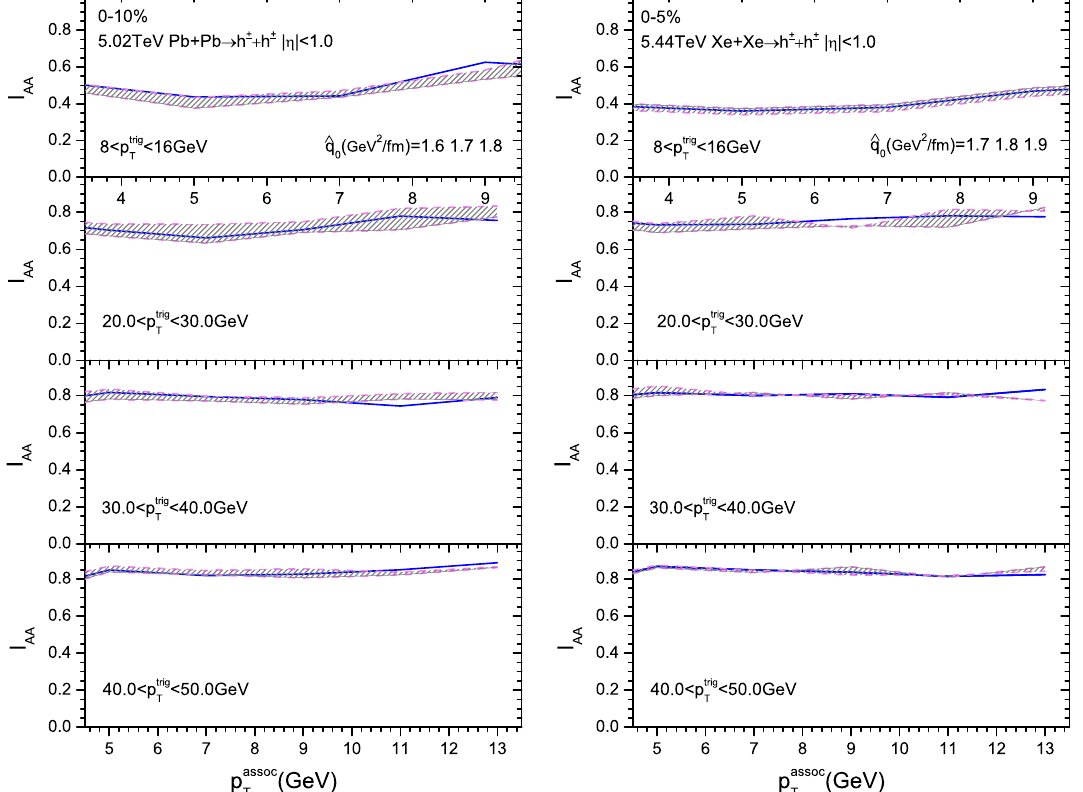
Fig. 8 The predictions of dihadron suppression factors in central Pb+Pb collisions at s NN = 5 . 44